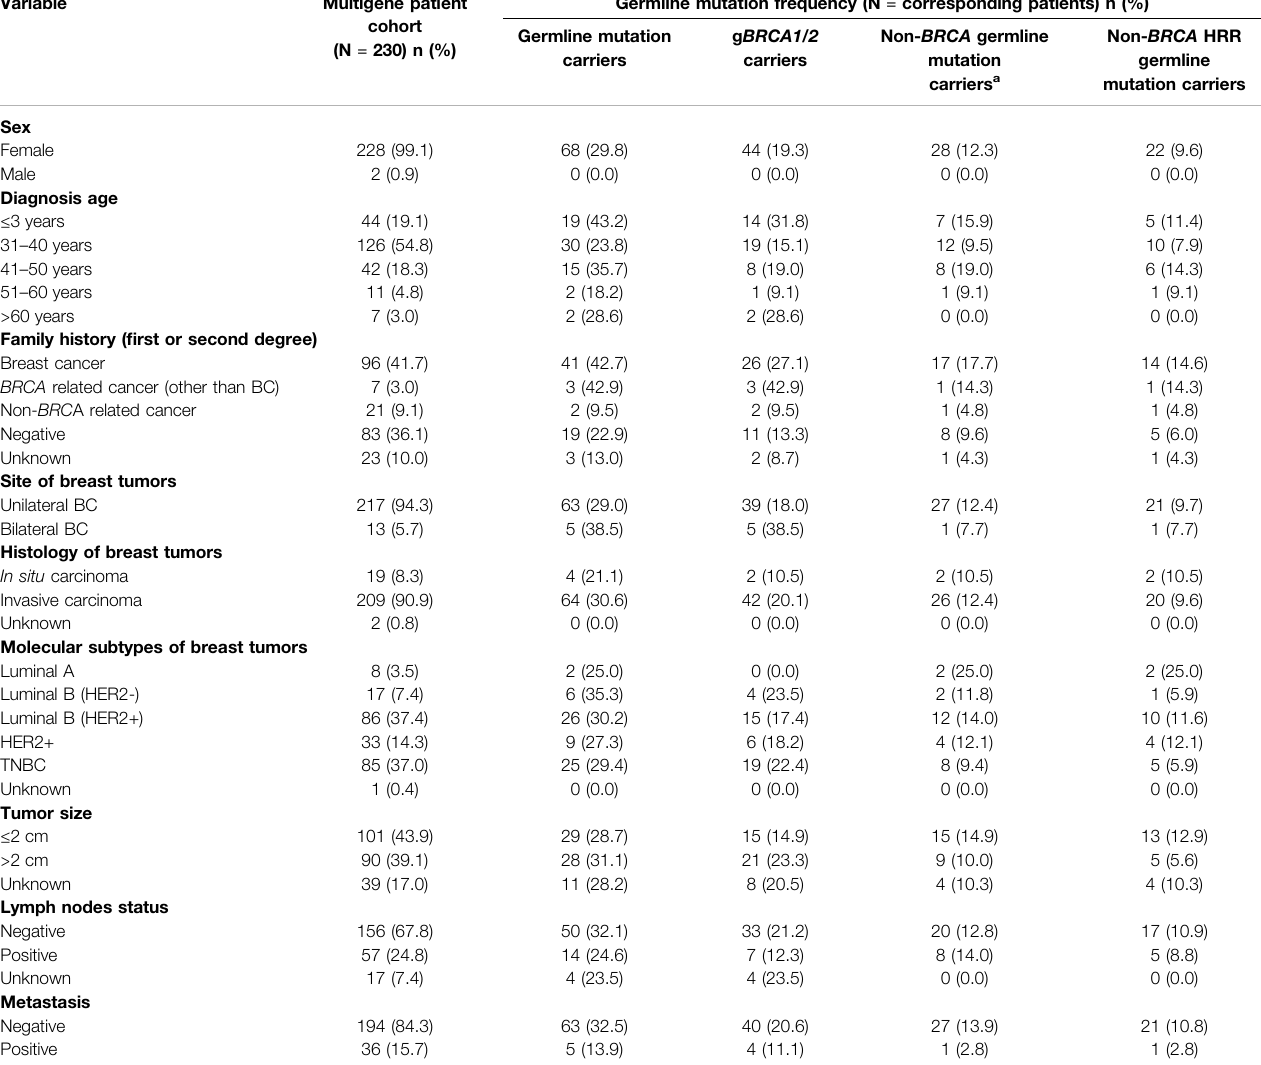
TABLE 1 | Clinicopathologic Data of 230 High Risk Breast Cancer Patients. Variable